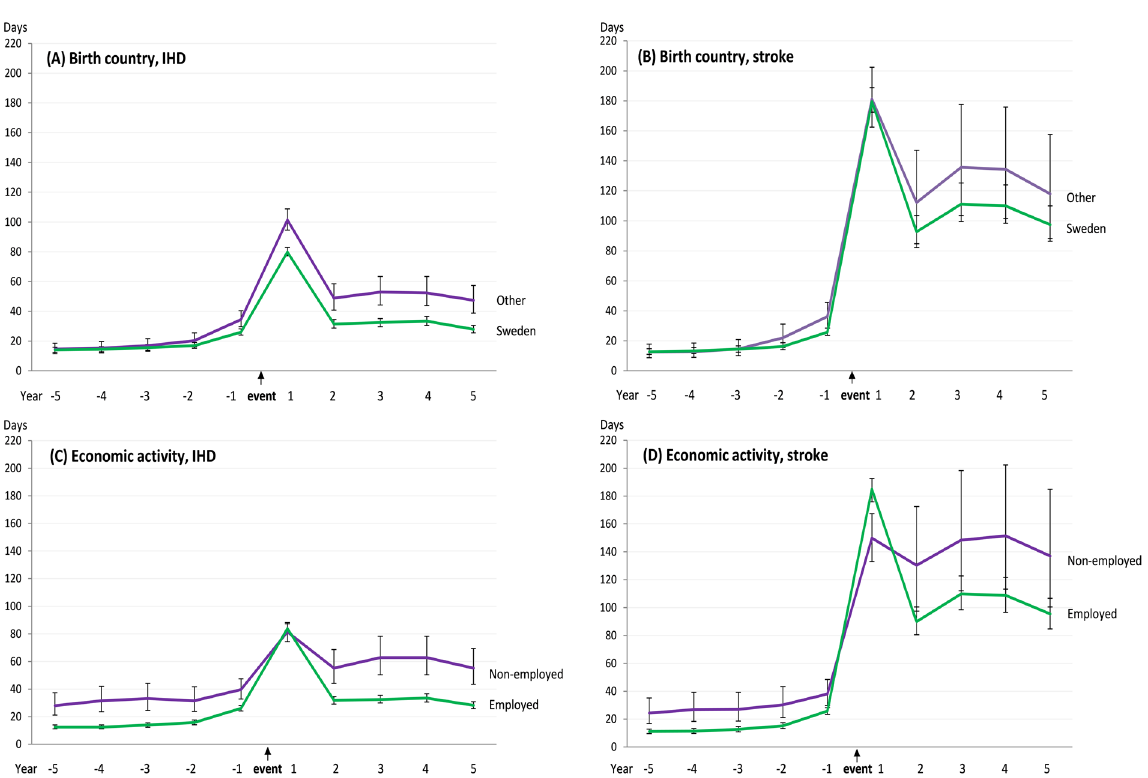
Figure 2. Mean days (95% confidence intervals) of work disability 5 years before and 5 years after newly diagnosed ischemic heart disease (IHD) or stroke event, by birth country and economic activity (adjusted for age, sex, and